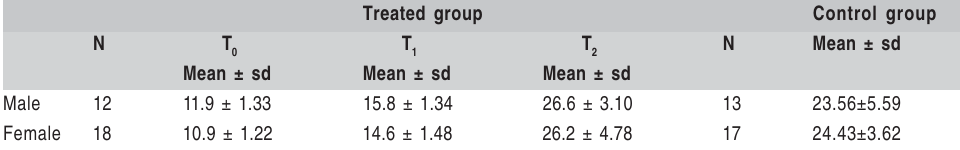
Table 1 - Mean and standard deviation (sd) of ages (in years) at time intervals T for both genders in the treated and control